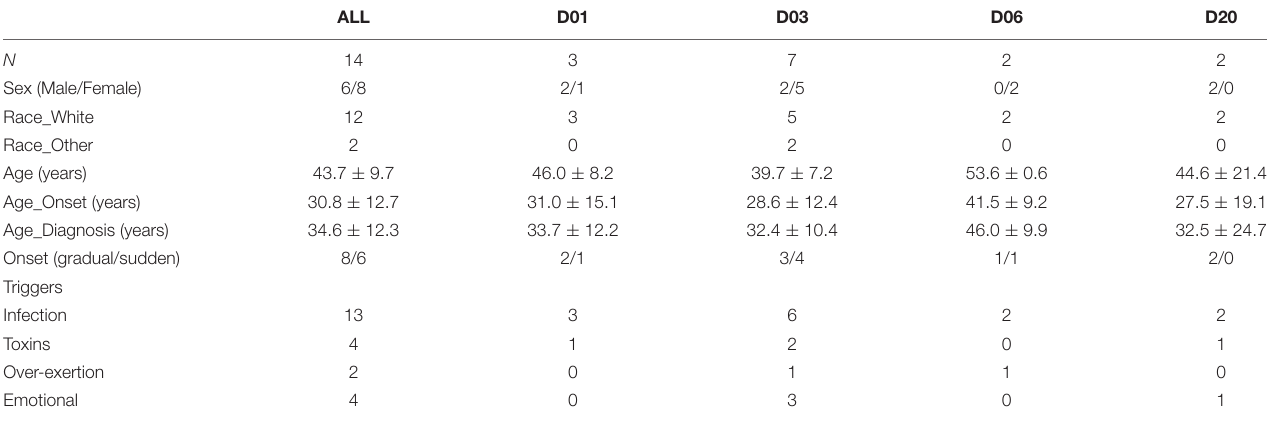
Age, Age_Onset and Age_Diagnosis indicate mean ± standard deviation.